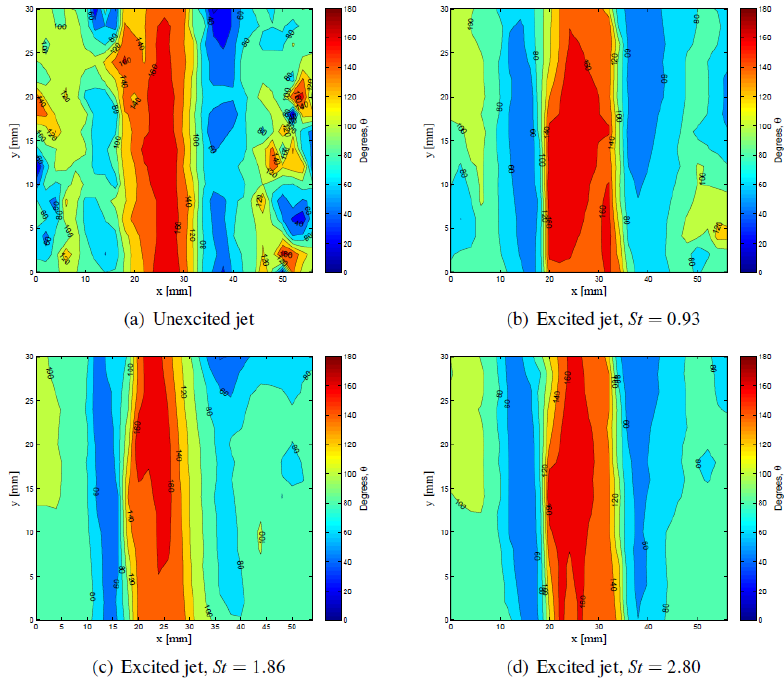
Figure 7. Average helicity angle, θ , on the z = 0mm plane: (a) for an unexcited jet; (b) for an excited jet with St = 0.93; (c) for an excited jet with St = 1.86; and (d) for an excited jet with St = 2.80.